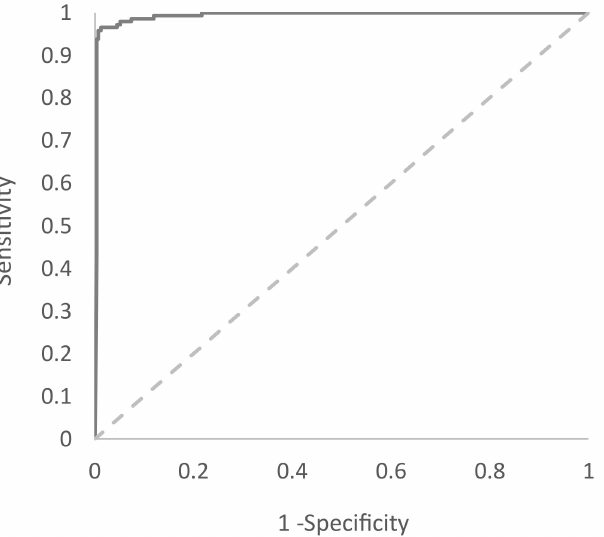
Figure 9. Diagnostic accuracy of Anti-HIV-1/2 UCNP-LFA. Receiver operating characteristic (ROC) of the UCNP-LFA was calculated based on 145 anti-HIV-positive and 309 anti-HIV-negative samples. The area under the curve (AUC) is